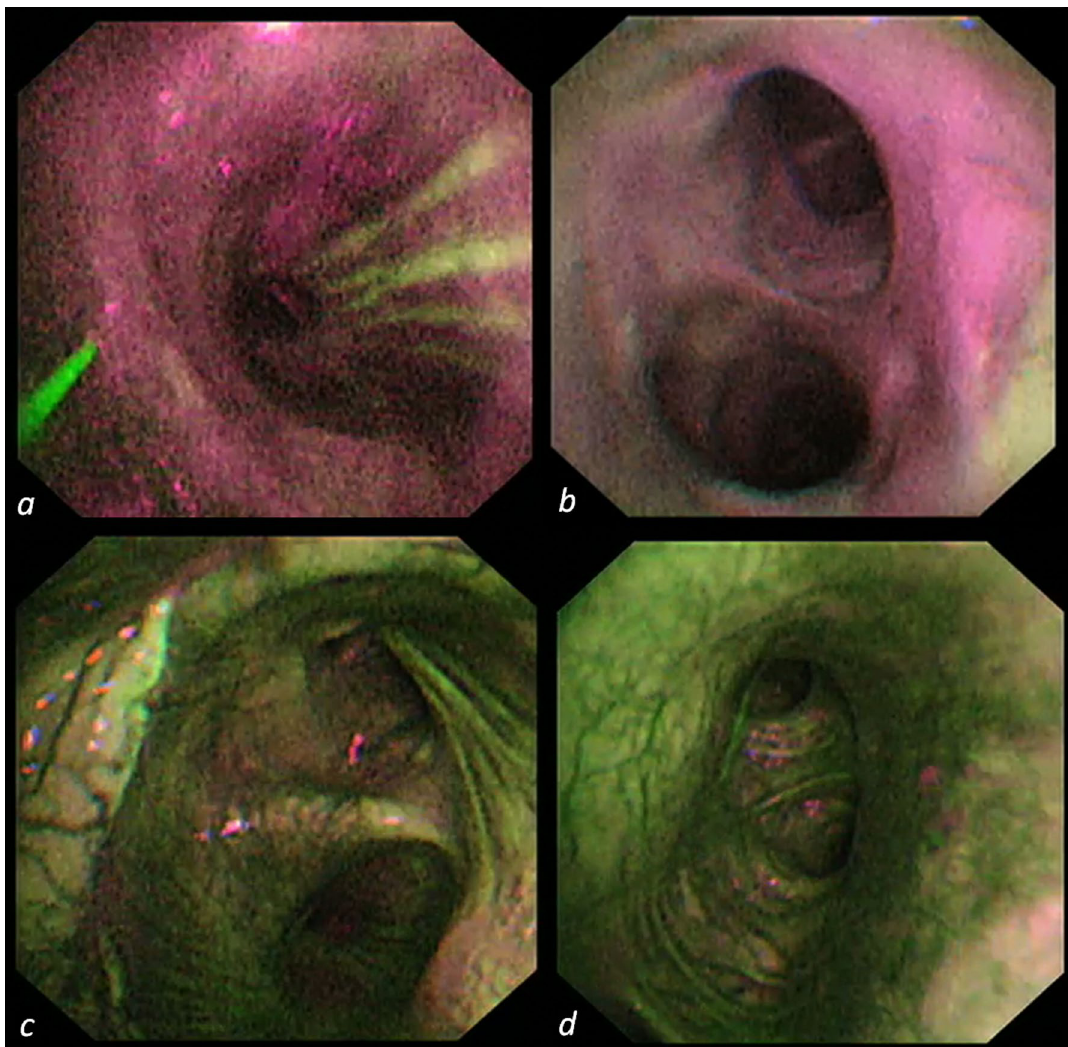
Figure 1. AFI appearance of first bronchial carina after bronchial anastomosis at baseline ( a ), POD28 ( b ), 6 months ( c ) and 1 year ( d ) after The same physician (RC) performed all procedures. Figure 1 shows AFI bronchoscopy at different time- points after LuTx.